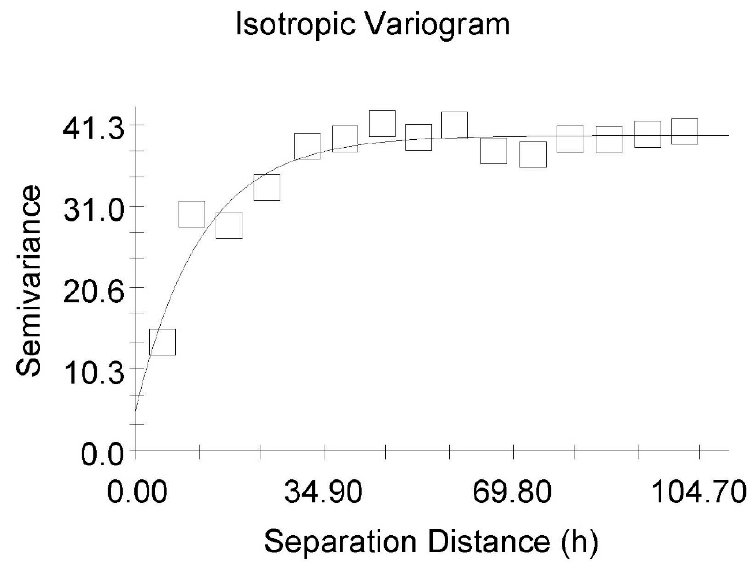
Figure 3. Semivariogram of VMC in the heading stage with an exponential model.